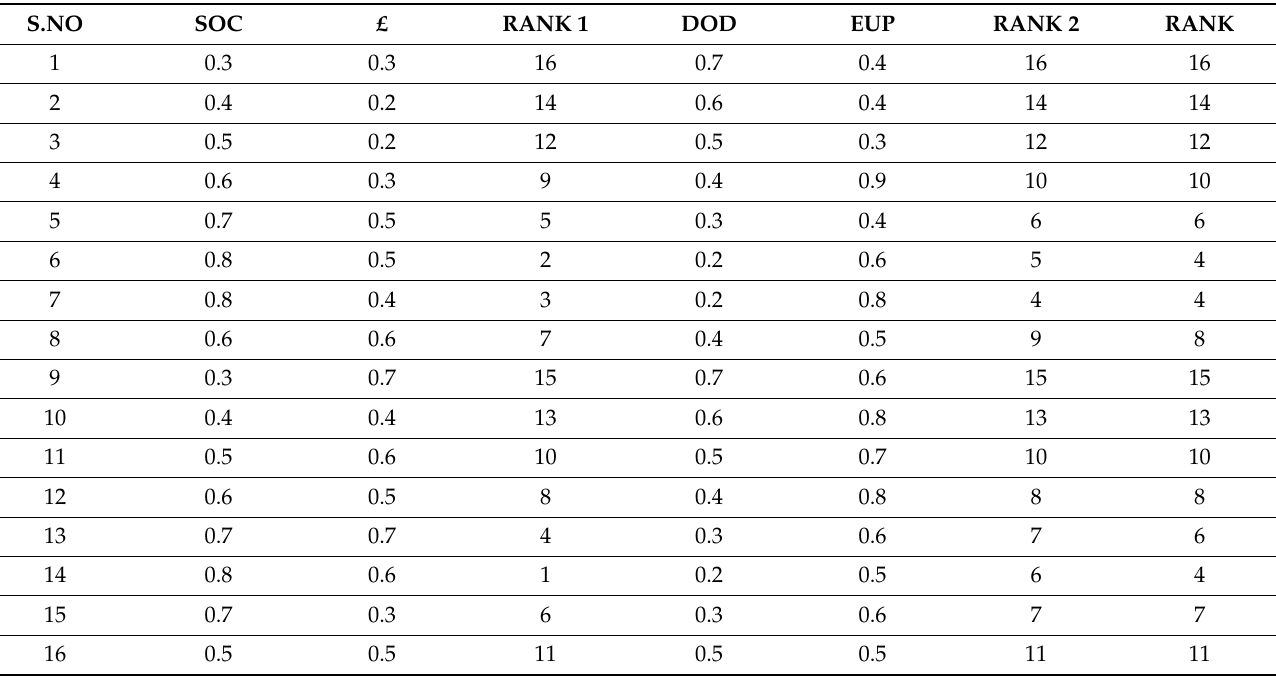
Table 4. Decision parameters mapping (discharging case).